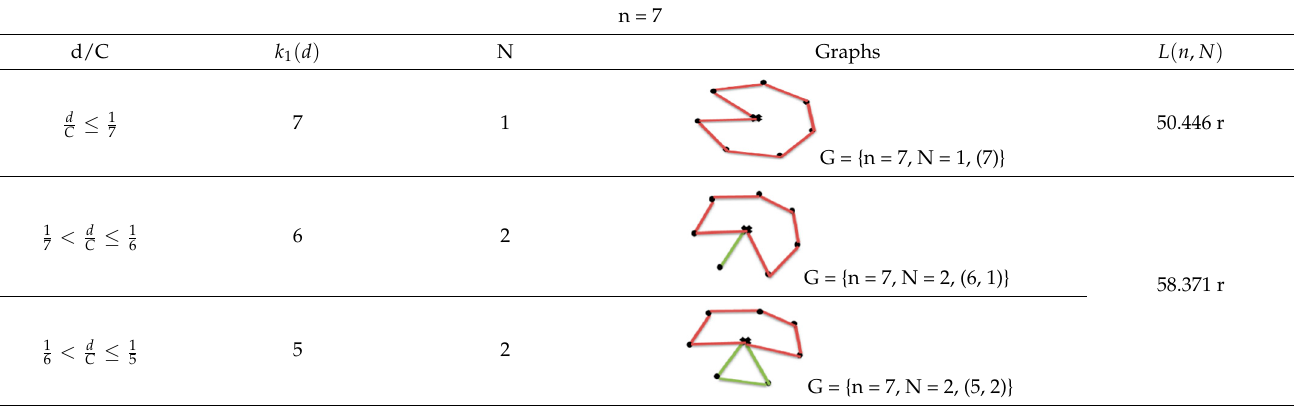
Table 1. Domains of d, corresponding graphs and lengths L ( n, N ) of the paths travelled by the set of optimum number of drones necessary for the logistics distribution, when zone contains n = 7, 8, and 9 vaccination centres, respectively.